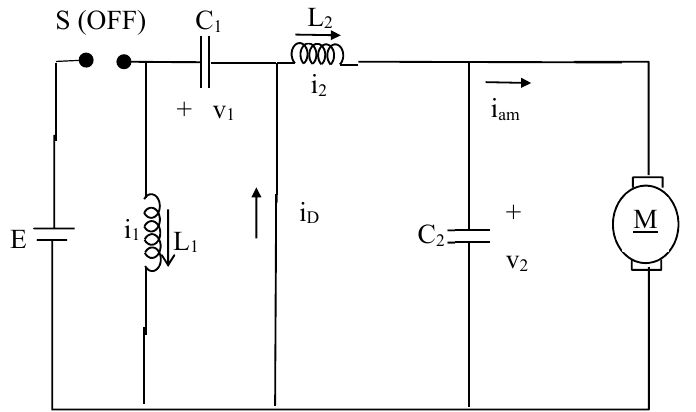
Figure 3. Converter status when the switch is off (motor field circuit is omitted).